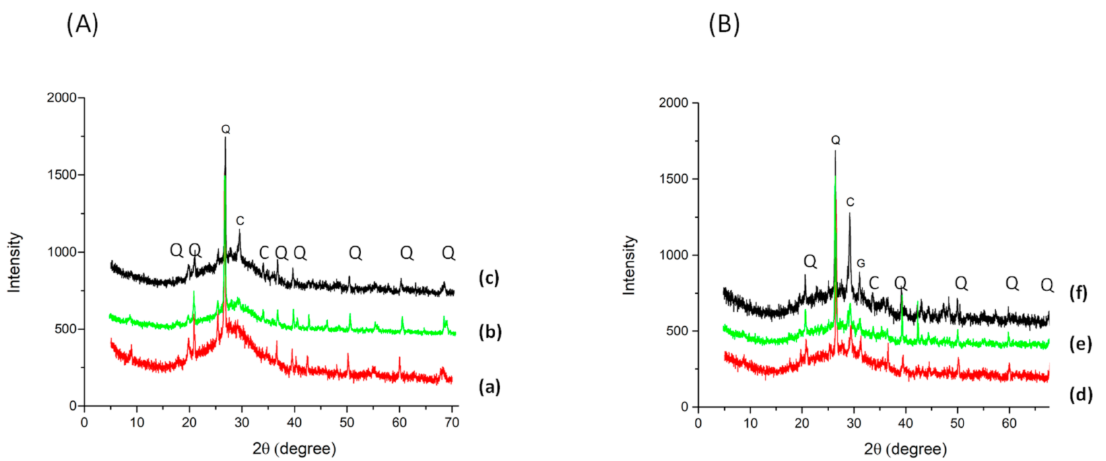
Figure 6. XRD patterns of ( A ) the first series: (a) MK100%, (b) MK + 20%Biochar and (c) MK + 70%Biochar and ( B ) the second series: (d) 50%MK/50%IBA, (e) 50%MK/50%IBA + 20%Biochar and (f) 50%MK/50%IBA + 70%Biochar (C = calcite; Q = quartz; G = gehlenite) at 90 days of